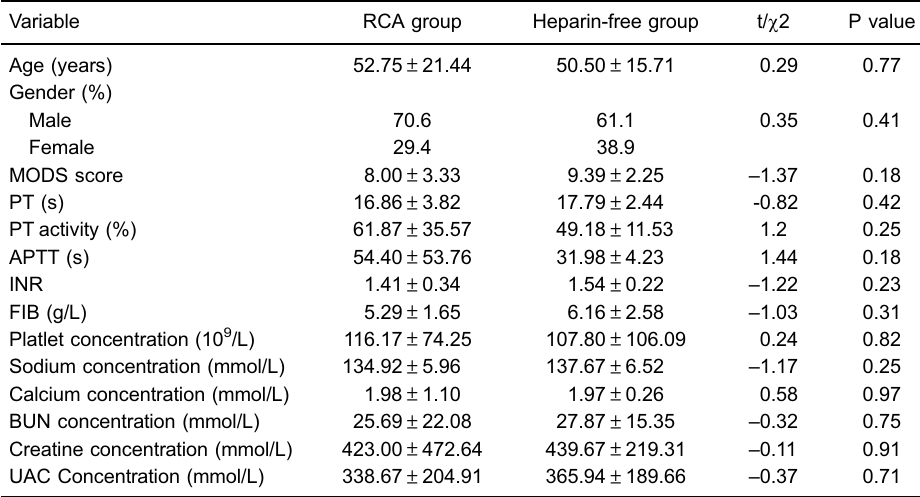
Table 1. Baseline characteristics of patients with multiple organ dysfunction syndrome (MODS) at the initiation of blood puri fi cation.